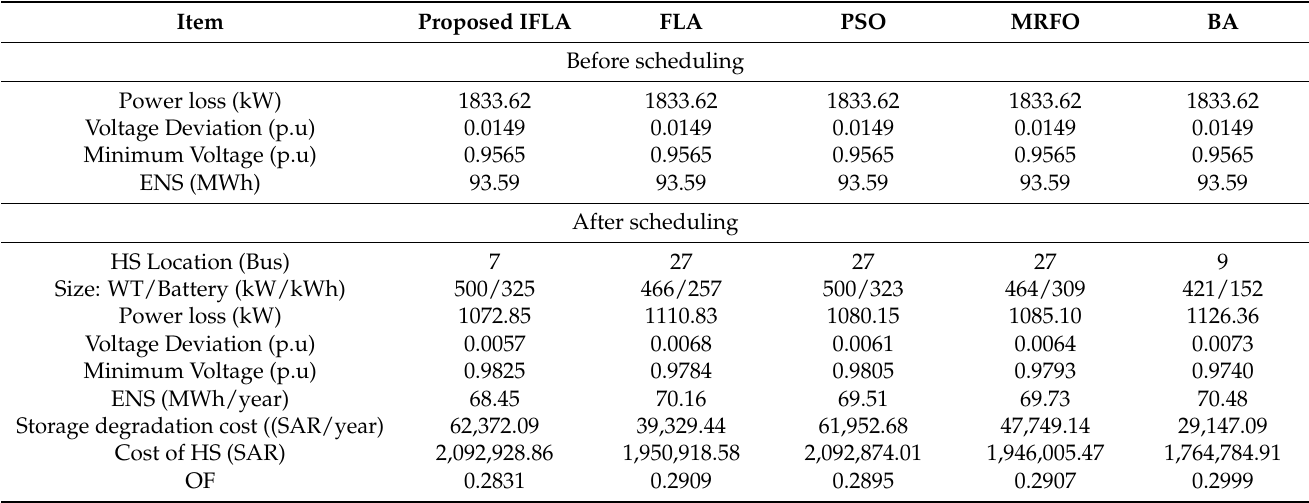
Table 5. The numerical results of different methods of hybrid WT/Battery system scheduling without storage degradation cost for 33-bus distribution network.